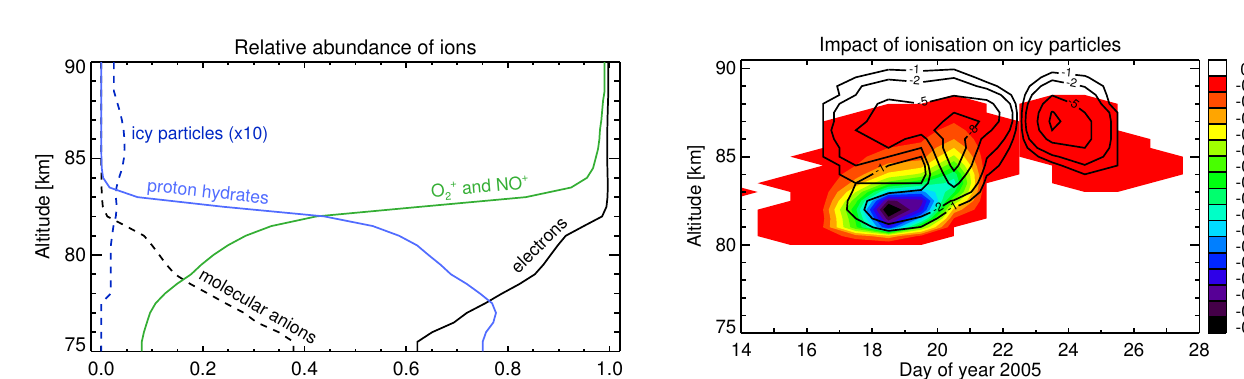
Fig. 11. Modelled total charge density during the SPE January 2005 at 75 ◦ S.